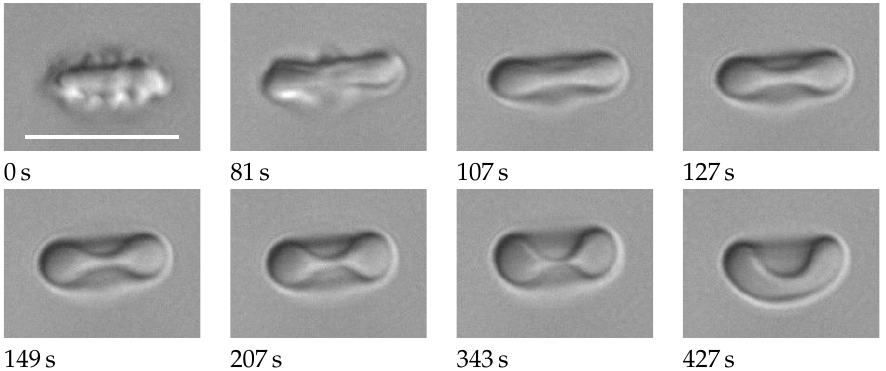
Figure 1. The shape of a red cell changes from echinocyte to stomatocyte. Photo montage from Movie S1 in Supplementary Materials. The suspending medium is phosphate buffered saline with a slowly increasing concentration of albumin. Below the images, the actual times of the process are given. The actual concentrations of albumin are not known. They are >0 at 0 s, <2 g/dl at 427 s, and monotonously increasing in between. The scale bar indicates